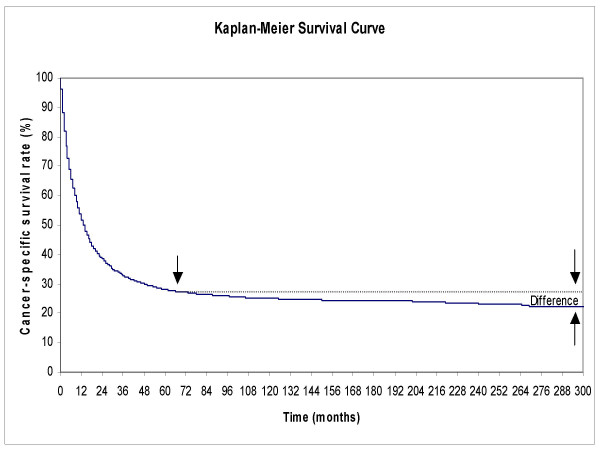
Cancer-specific survival rate of cancer patients who died of their disease calculated by Kaplan-Meier method. Note the small difference between the cancer-specific survival rate at τ year as compared to the long-term survival rate. The single arrow shows the location of the threshold year (τ). The pair of opposing arrows at the long-term follow-up shows that the difference between the estimated and actual cancer-specific rate is small, less than six percentage points. The survival time for cancer patients who died of their disease for stomach cancer is shown as an example.